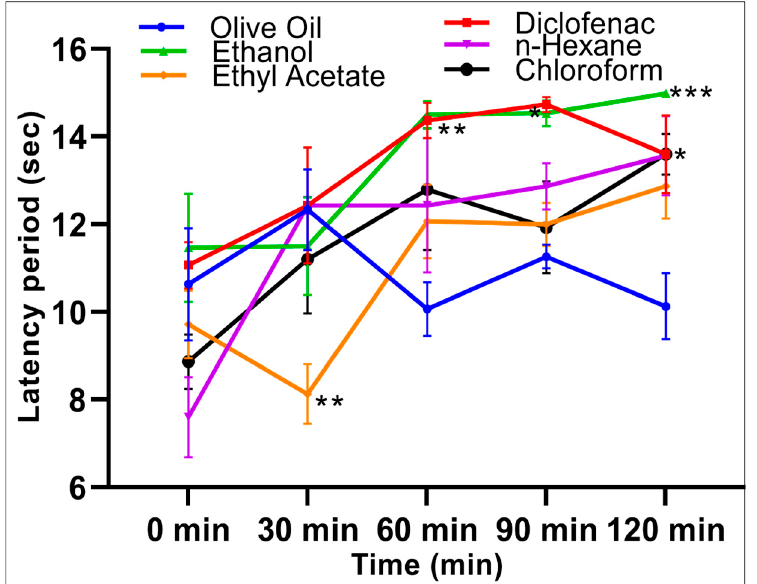
Figure 2. Analgesic effects of the S. cyclophylla extracts as assessed by the hot-plate pain-induction method in mice. Values are denoted as mean ± SEM, n = 6 animals/group. The statistical significance was performed via a one-way ANOVA followed by a posthoc test using Tukey’s multi-group com- parison: * p < 0.05, ** p < 0.01, and *** p < 0.001 compared to the olive oil control group. For example, at 120 min compared to the olive oil group, the diclofenac, n-hexane, and chloroform extracts groups were significantly different * p < 0.05.